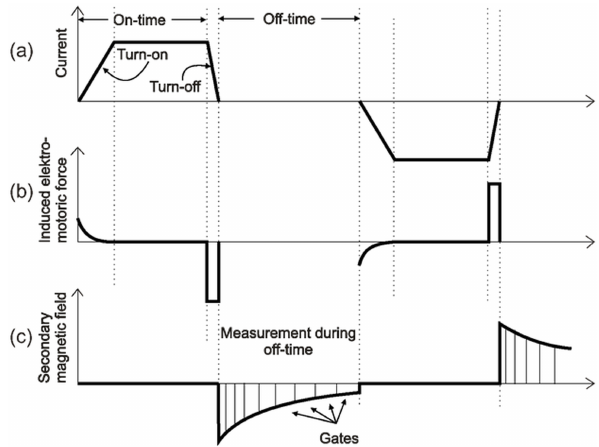
Figure 1. (a) Current injected in the transmitter loop. (b) The in- duced electromotoric force in the ground. (c) The secondary mag- netic field measured in the receiver coil. The listening time is during the off time (adapted from Christiansen et al., 2006).